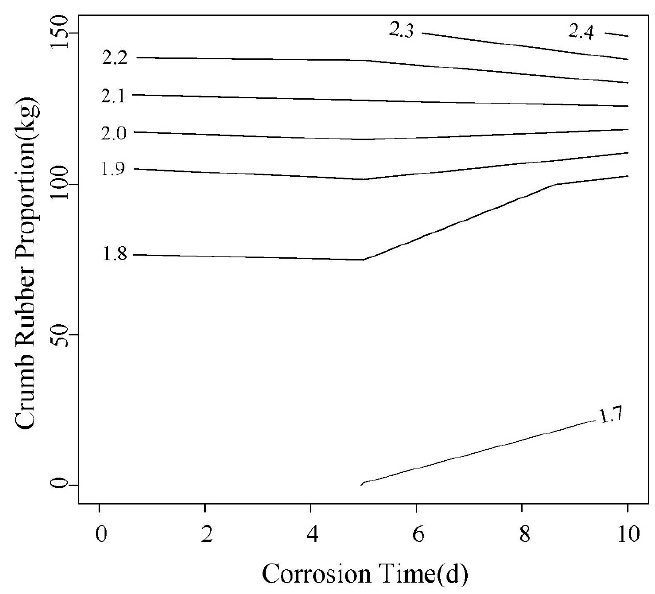
Figure 18. Equipotential line diagram of unit energy consumption corresponding to 2.5 mm displacement at mid-span of 0.55 water-cement ratio.